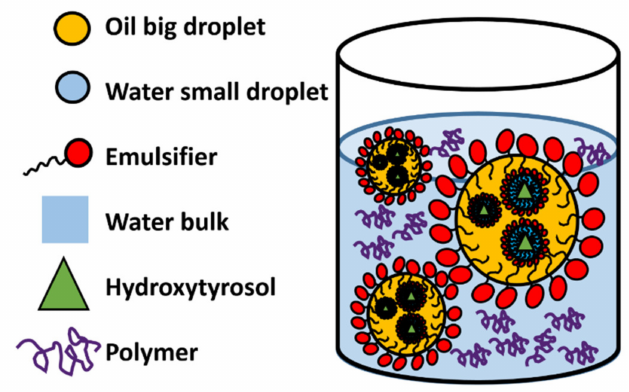
Figure 4. Schematic structure of gelled double water-in-oil-in-water emulsion (GDE) as possible system for hydroxytyrosol